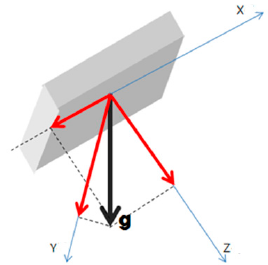
Figure 17. Trapezoid Integration.